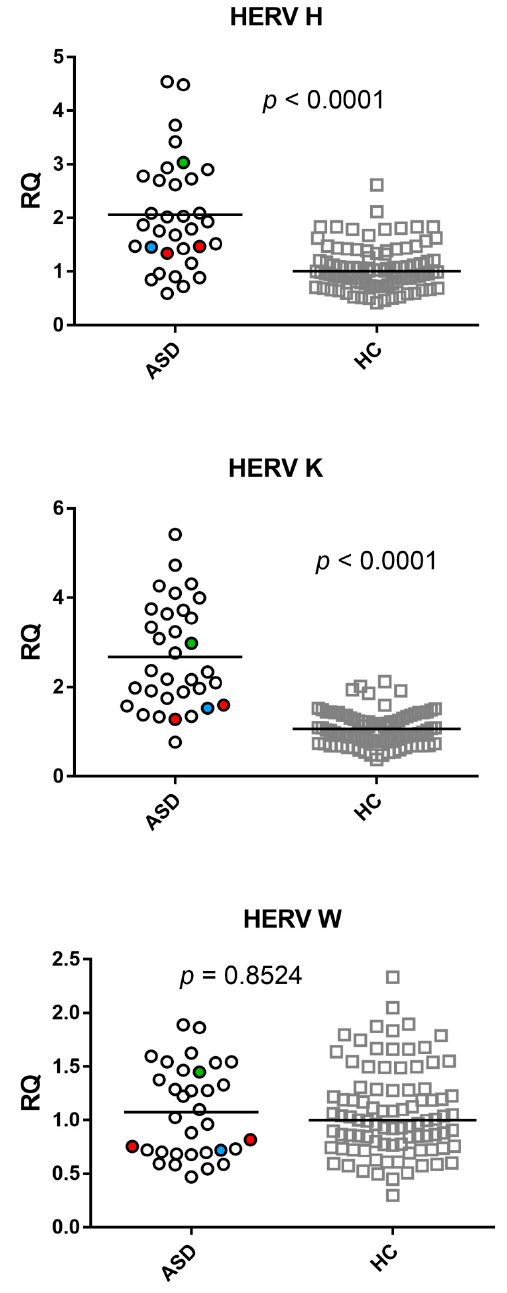
Figure 1. Transcription levels of pol genes of HERV-H, HERV-K, and HERV-W, in whole blood from 33 children with autism spectrum disorder (ASD) and 90 healthy controls (HC). RQ: relative quantification. Circles and squares show the median of three individual measurements, horizontal lines the median values. Red circles: values of two patients on valproic acid therapy. Green circle: value of the patient on aripiprazole therapy. Blue circle: value of the patient on cyproheptadine therapy. Statistical analysis: Mann–Whitney test was used to compare the transcriptional levels of each target gene between children with ASD and HC.